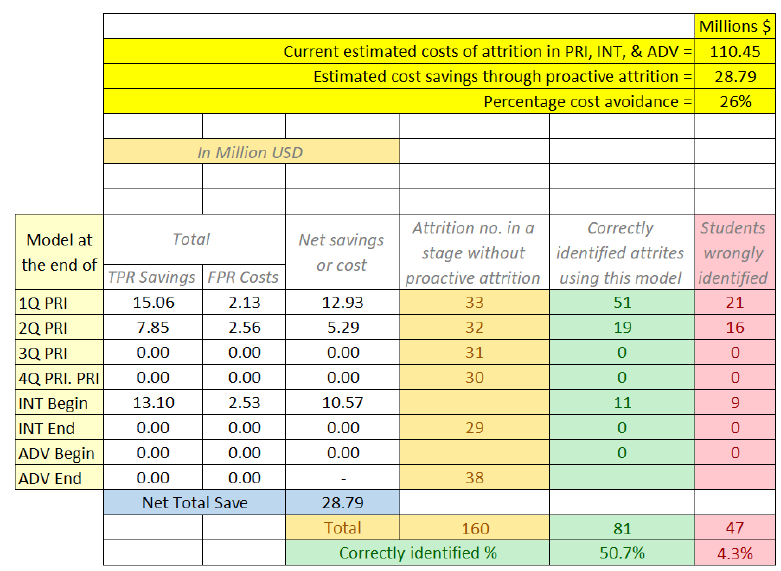
Figure 19. Cost savings generated and classification results produced by each selected model and net potential cost